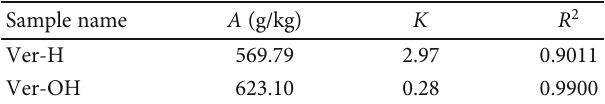
Figure 6: Langmuir model adsorption isotherms of vernadite for Pb 2+ . Table 3: Relevant parameters of Pb 2+ isothermal adsorption on vernadite by Langmuir equation fi